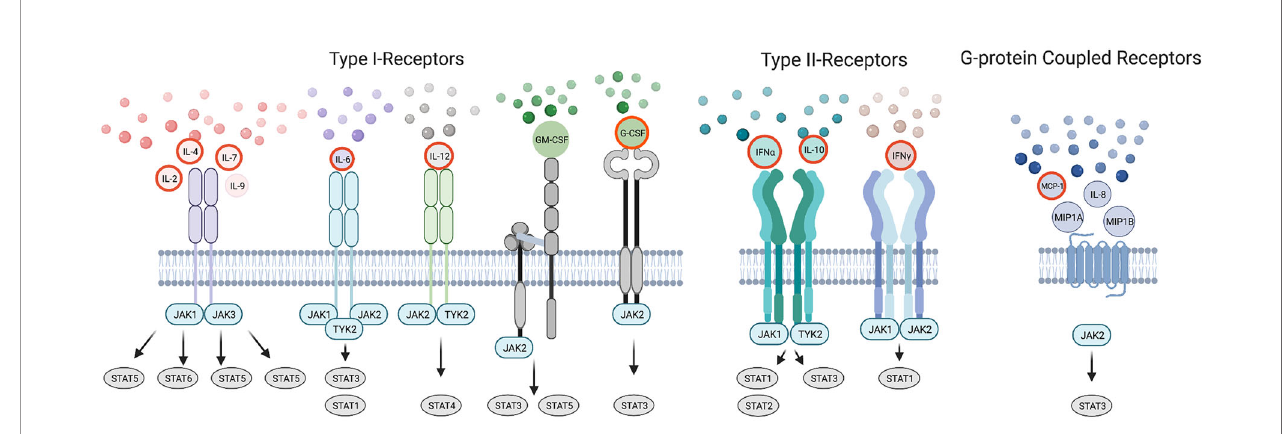
FIGURE 1 | The Cytokine Storm in COVID-19 Utilizes JAKs and STATs. A simple schematic showing elevated cytokines in COVID-19 signaling by Type I, Type II, Immunoglobulin, and G-protein coupled receptors with those correlated to disease severity outlined in red. Paired JAKs are seen signaling immediately downstream of receptors directly activating STATs (solid line).Only the predominantly activated STAT is depicted for shown